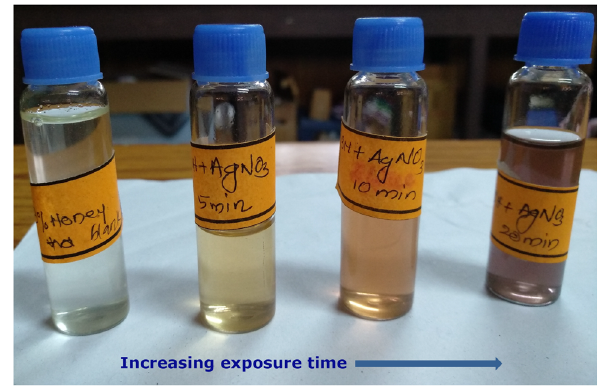
Figure 1: Color change of the solution mixture with an increase in